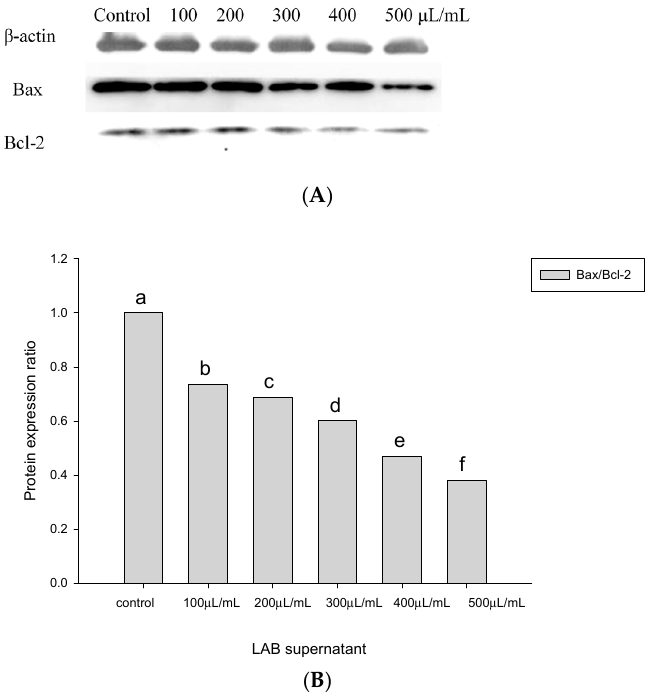
Figure 3. Effect of BCRC14625 supernatant on the level of Bax/Bcl-2 in the HT-29 cell line. The control means untreated cells. ( A ) Protein products of Bax and Bcl-2 extracted from the HT-29 cell line; ( B ) Bars represent the protein expression ratio of Bax/Bcl-2 in the HT-29 cell line.